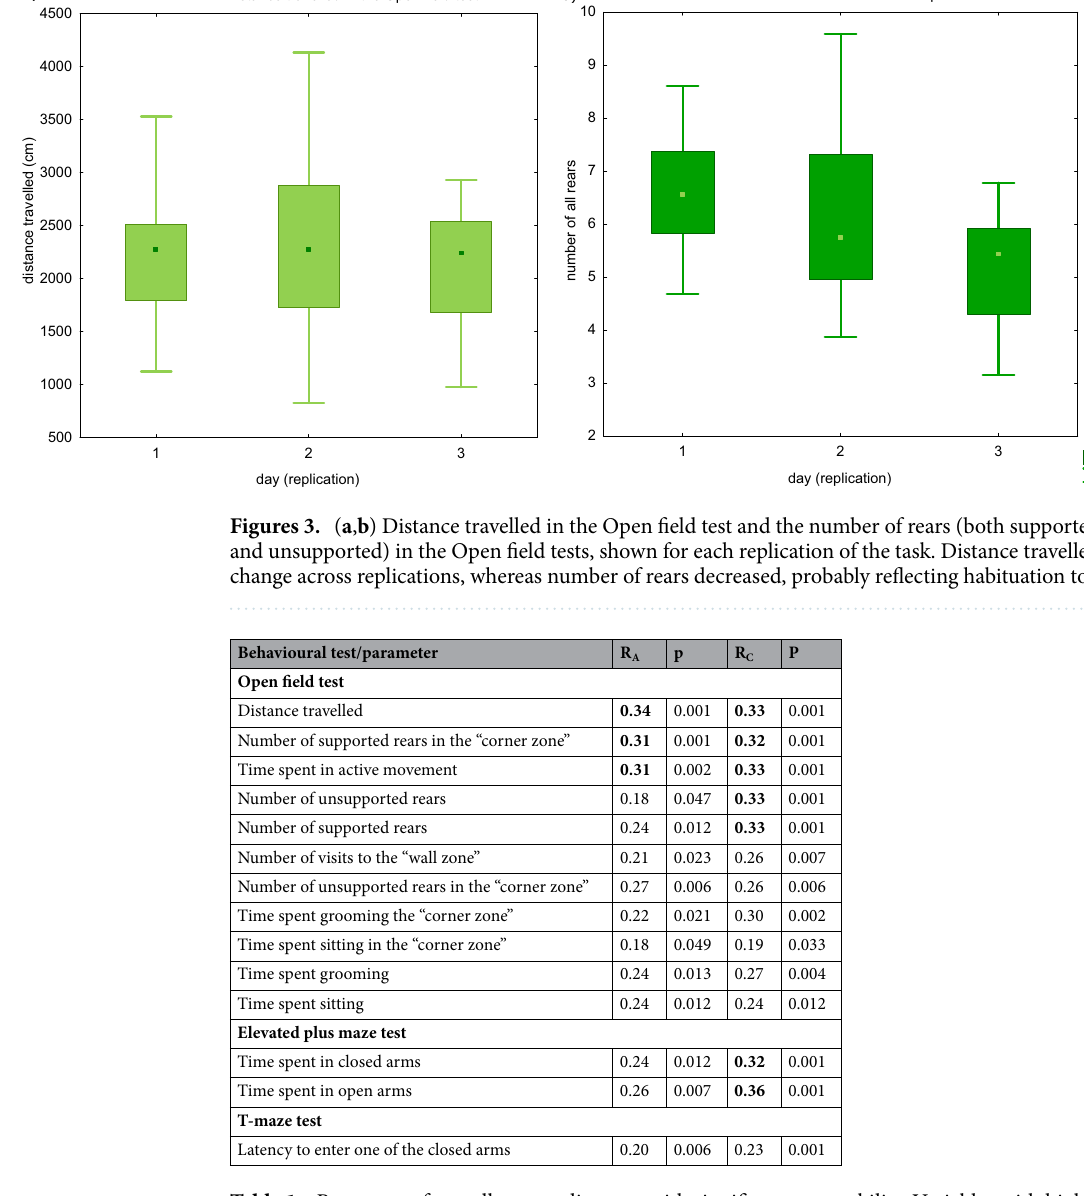
Table 1. Parameters from all personality tests with significant repeatability. Variables with higher repeatability scores than 0.3 are in bold. R A = agreement repeatability, R C = consistency